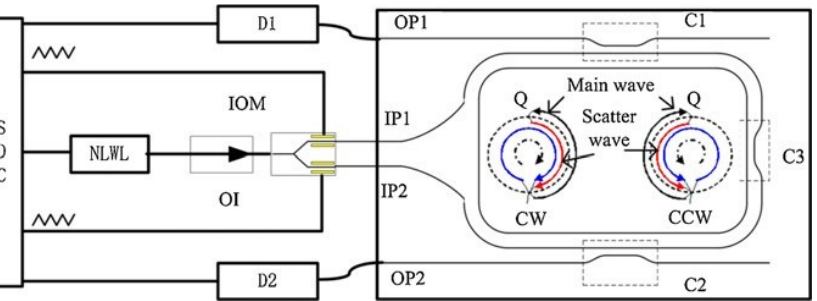
Figure 3. The configuration of the SPMT using the same triangular wave. SDC, NLWL, OI, IOM, OP1(2), IP1(2), and D1(2) represent the signal detecting circuit, laser, optical isolator, integrated optical modulator, output1(2), input1(2), and optoelectronics detector1(2), respectively. Reprinted with permission from ref. [16]. Copyright 2011